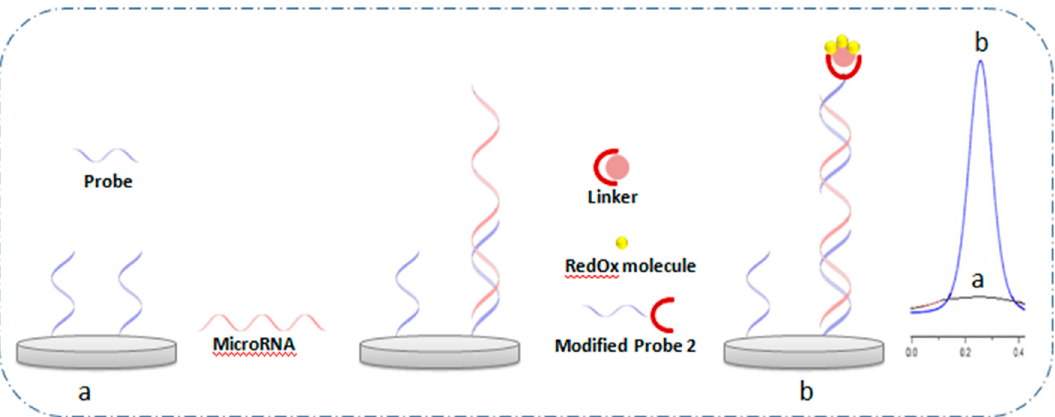
Figure 5. Architecture of electrochemical biosensor based on a RedOx molecule labeled probe via a linker molecule ( a ) before and ( b ) after hybridization.